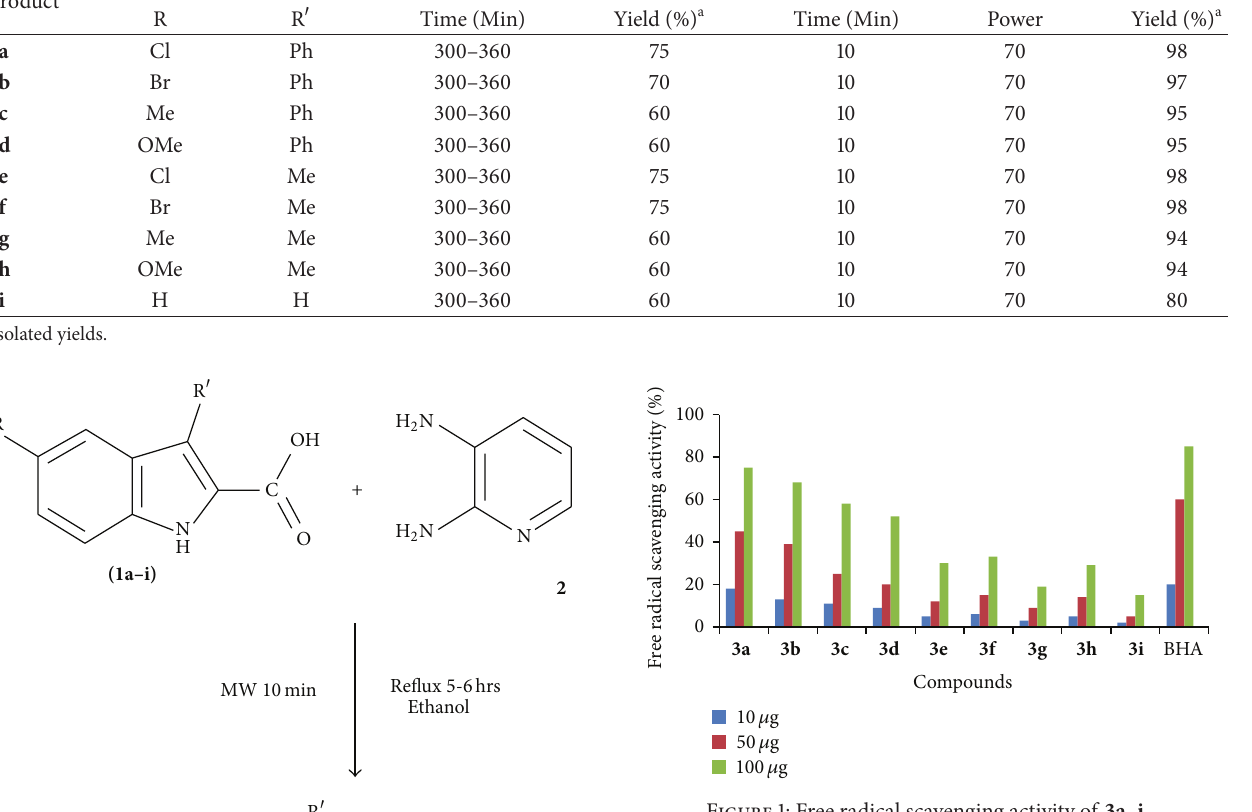
Figure 1: Free radical scavenging activity of 3a–i